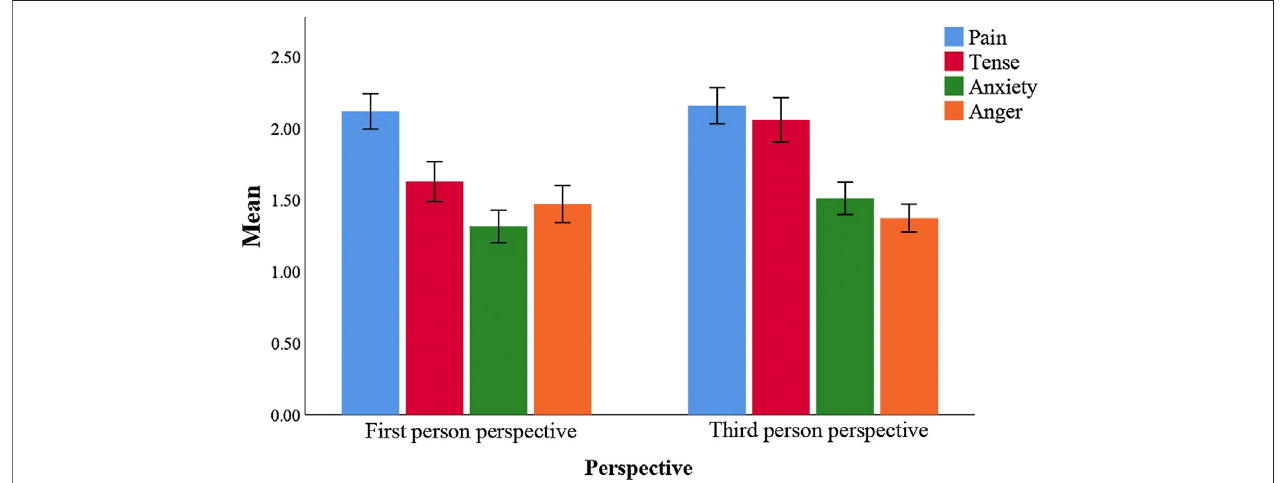
FIGURE 4 | Mean VLS scores for the fi rst person (left) and third person (right) conditions. Error bars are 95% CI.